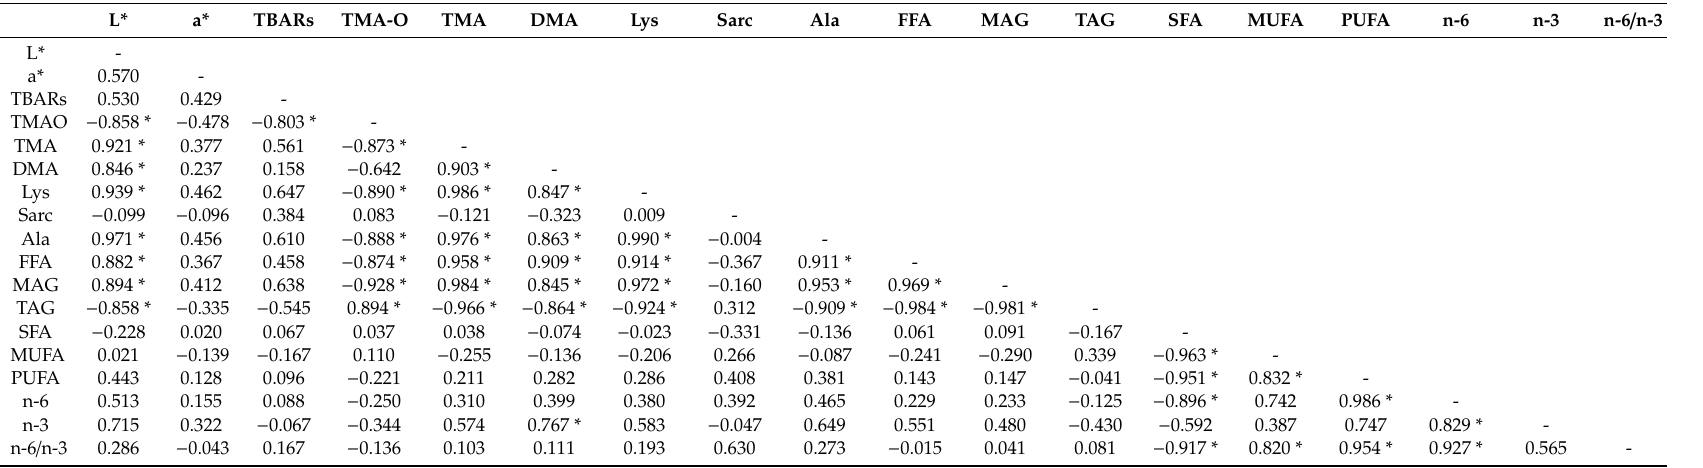
Table 5. Correlation matrix among measured quality parameters of mechanically separated mantis flesh, after storage at di ff erent